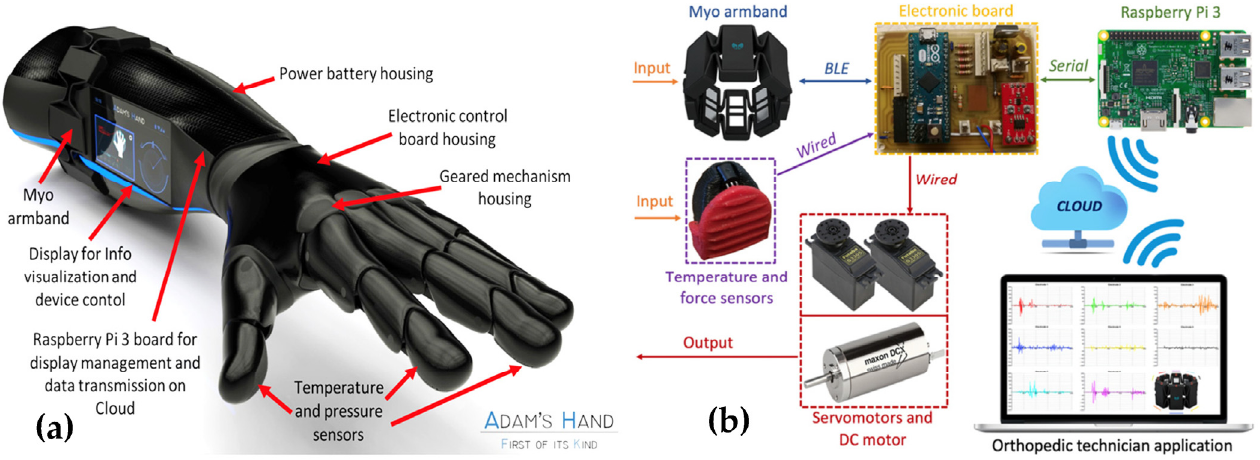
Figure 5. Transradial prosthesis based on the Myo wireless myoelectric armband proposed in